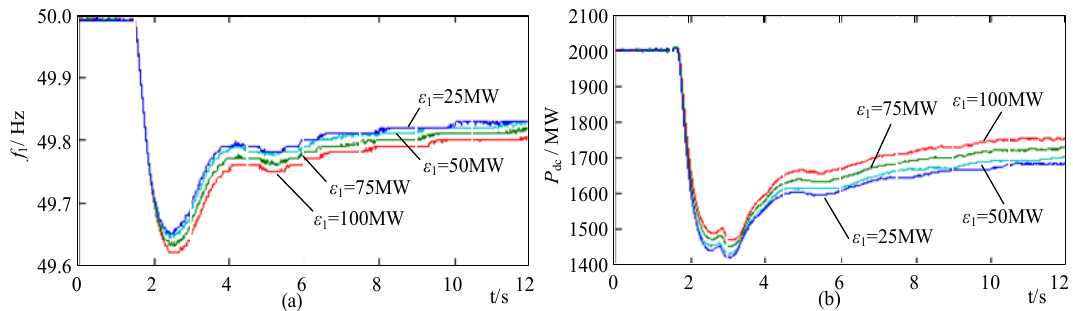
Figure 15. Response characteristics with droop control dead zone changes. ( a ) The frequencies of the sending-end system; ( b ) the actual power transmitted by the UHVDC.